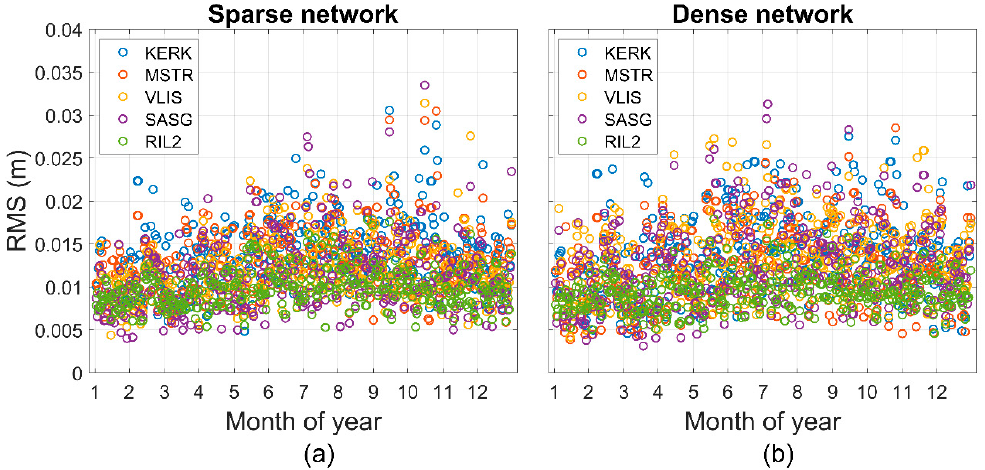
Figure 10. RMSEs of the prediction errors for the user stations outside the ( a ) sparse network and ( b ) dense network.